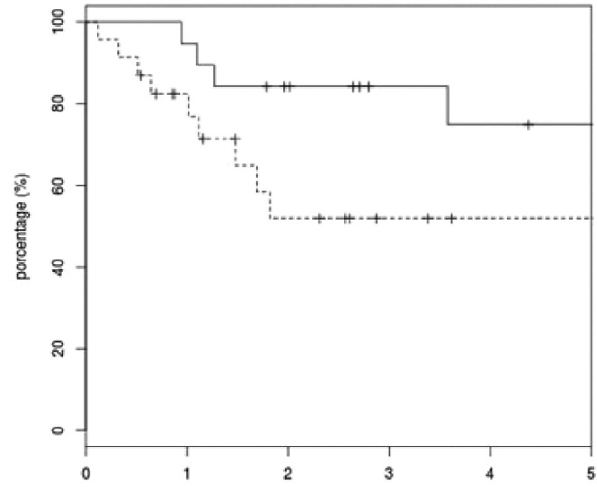
Figure 2 - Kaplan-Meier analysis of 5-year survival free of distant metastases comparing Pex (---) with Unpex (—). Pex: 51.9% 6 Unpex: 74.9% ( p =0.07).